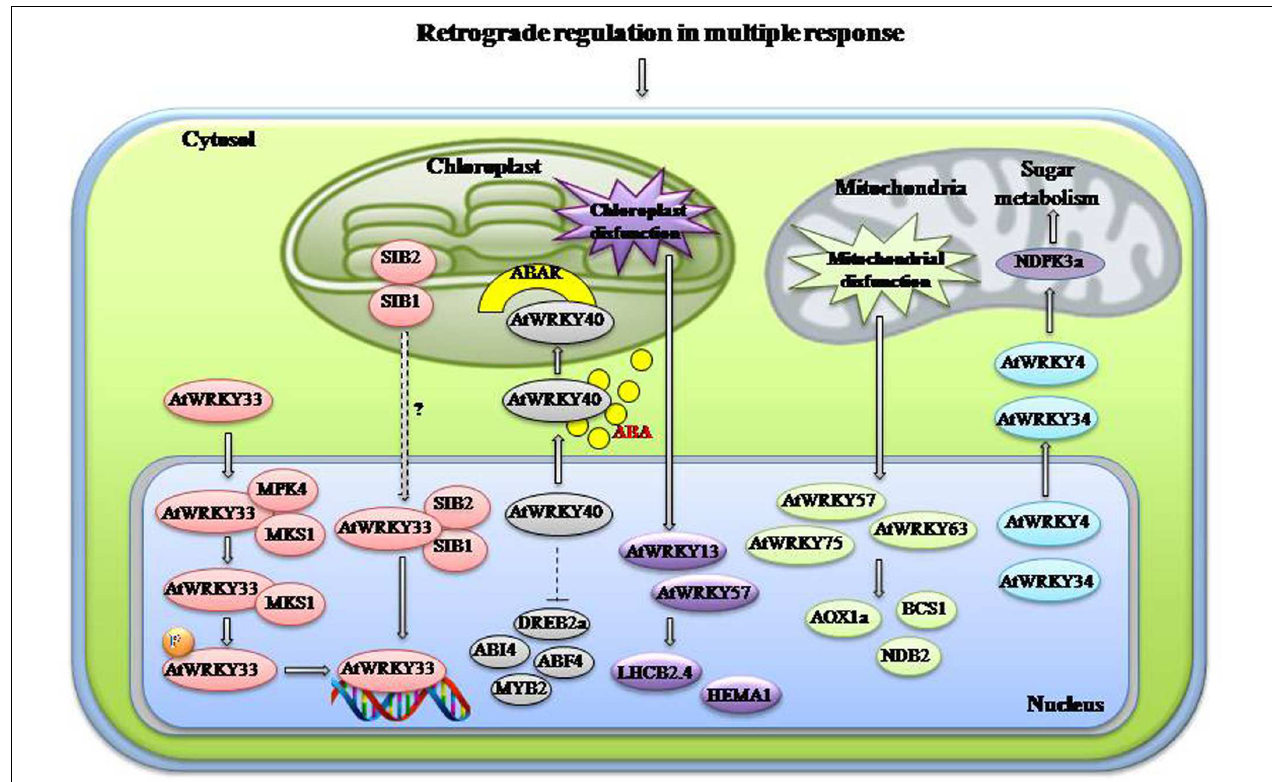
FIGURE 3 | Retrograde regulation in multiple responses. WRKYs play an imortant role in organellar interactions. During plastid disfunction AtWRKY13/40/57 are activated which regulate chloroplast associated genes like LHCB2.4 and HEMA1. Under normal condition AtWRKY40 represses expression of stress-responsive genes like DREB2a, ABI4, ABF4, and MYB2. When ABA is accumulated under stress it leads to translocation of AtWRKY40 to the chloroplst membrane located protein ABAR so that expression of stress-responsive genes could be elevated. Chloroplst targeted proteins SIB1/2 help in the activation and binding of AtWRKY33 to the promoter of downstream genes with the help MAPK4 and MKS1. Mitochondrial disfunction also activates certain WRKYs like AtWRKY57/63/75 which in turn activates mitochondria associated genes AOX1a, BCS1, and NDB2. AtWRKY4/34 regulate NDPK3a and sugar metabolism probably through mitochondrial retrograde signaling. Abbreviations: ABAR, ABA receptor; NDPK3a, Nucleoside diphosphate kinase 3a; ABF4, ABRE-binding factor 4; MPK4, Mitogen activated protein kinase 4; MKS1, MAP kinase substrate 1; SIB, Sigma factor binding protein; ABI4, ABA insensitive 4; LHCB, Photosystem II chlorophyll a/b-binding polypeptide gene; AOX1a, Alternative oxidase 1a; NDB2, type II NAD(P)H dehydrogenases